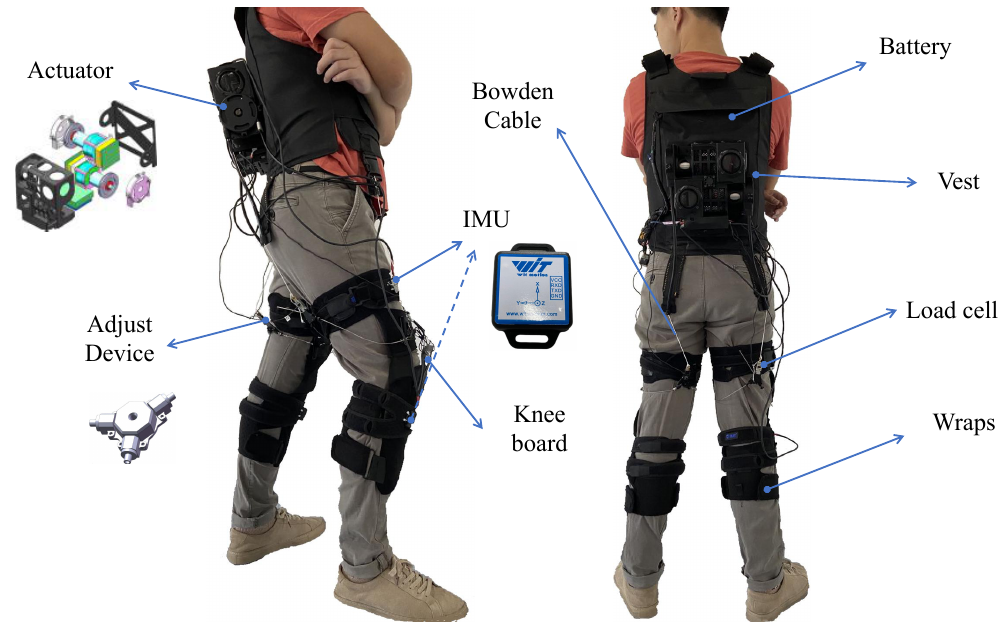
Figure 1. The system overview is showing the structure of the soft exoskeleton and the position of its every